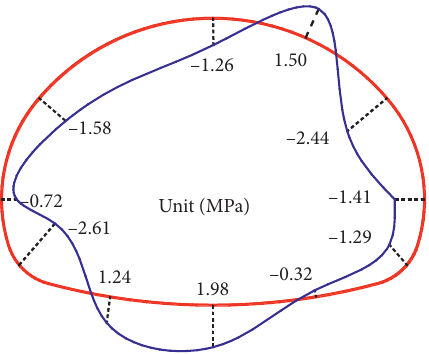
Figure 11: Maximum stress distribution of shotcrete at YK2+133